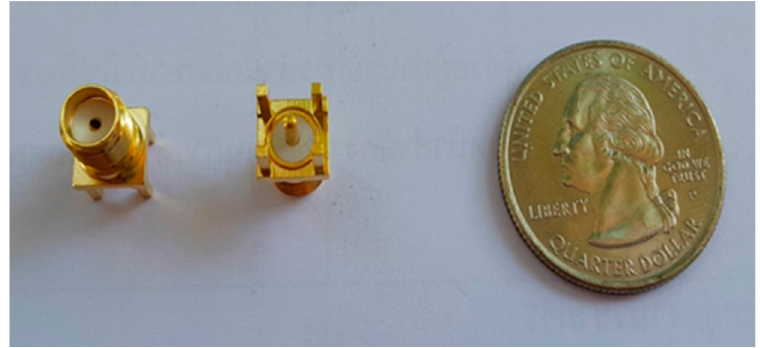
Figure 2. A photograph of SMA connectors.